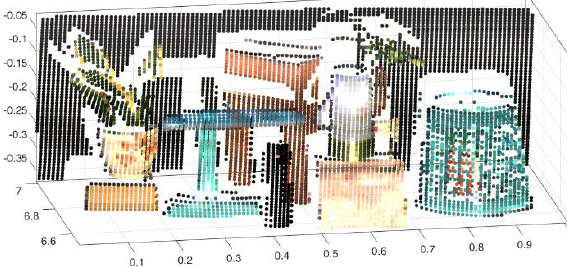
Figure 3. Multispectral lidar point cloud after the reference target-based radiometric calibration.